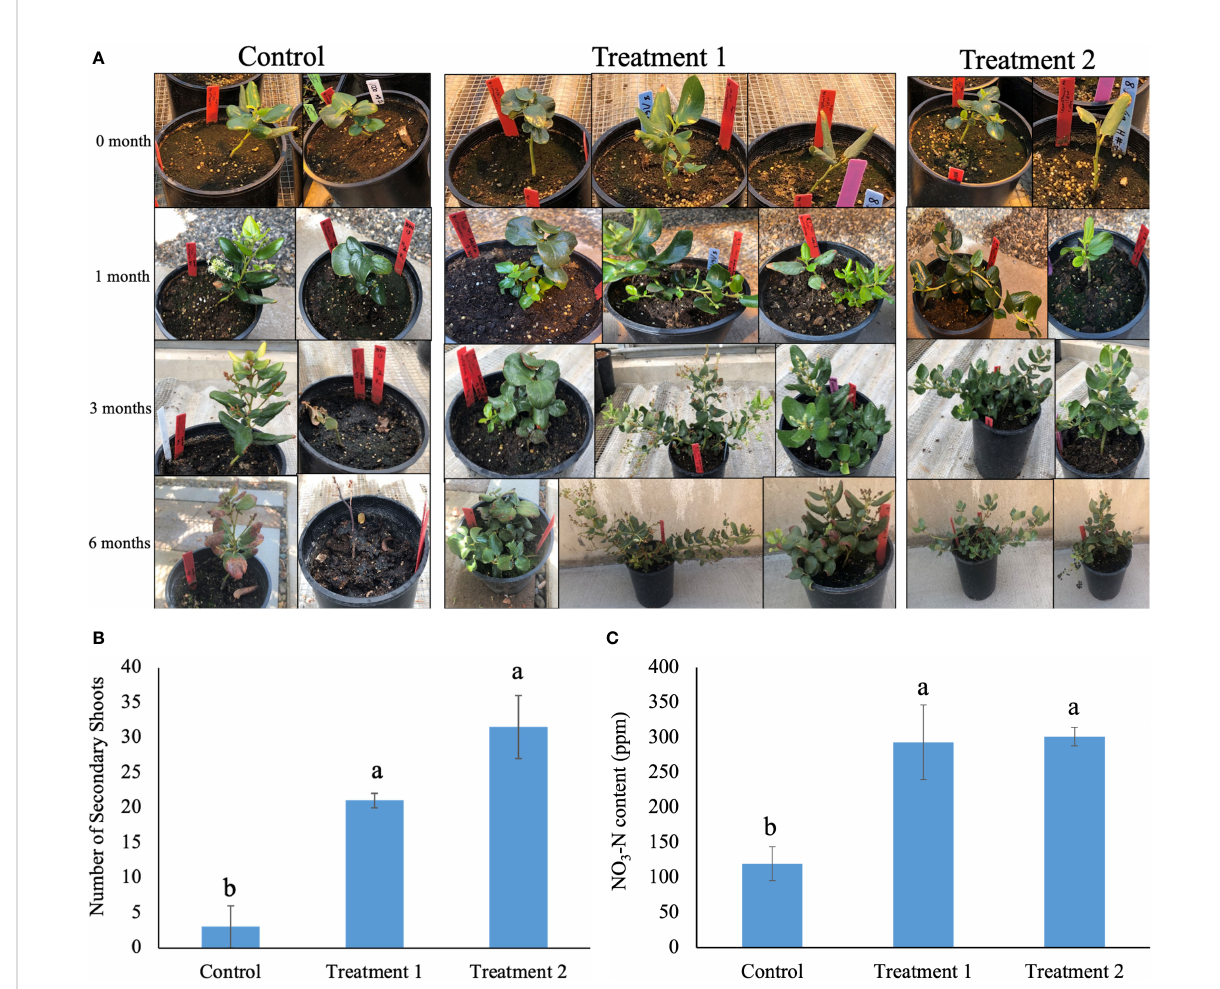
FIGURE 1 (A) Change in the growth of snowbrush ceanothus plants (with and without native soil) in six months. The plants treated in treatment 1 (native soil form location 1965m AMSL), and treatment 2 (native soil from location 2289m AMSL) showed bigger plants compared to control plants (not treated with native soil). The pot diameter is 16cm. (B) Signi fi cant increase in the number of secondary shoots of snowbrush ceanothus plants from cuttings treated with native soil (Treatment 1 and 2) compared to control plants after six months of treatment. (C) Signi fi cant increase in nitrate- nitrogen (NO 3 -N) content of snowbrush ceanothus plants after six months of treatment compared to control. The same letters denote no signi fi cant difference among treatments by Tukey ’ s method for multiplicity at a <